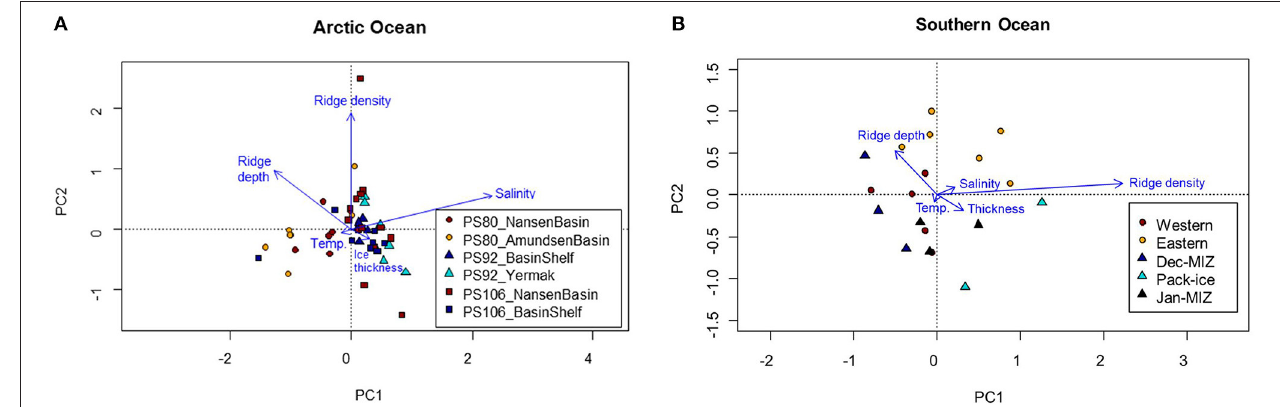
FIGURE 6 | Principal component analysis for the Arctic Ocean and the Southern Ocean. In the Arctic Ocean (A) , stations are divided within each expedition between Nansen and Amundsen basin (PS80), Yermak and Basin & shelf stations (PS92), and Basin & shelf stations vs. Western stations in the Nansen Basin (PS106). In the Southern Ocean (B) , stations are divided between westernmost and eastermost stations (PS81), and between January MIZ, December MIZ, and pack-ice stations (PS89).